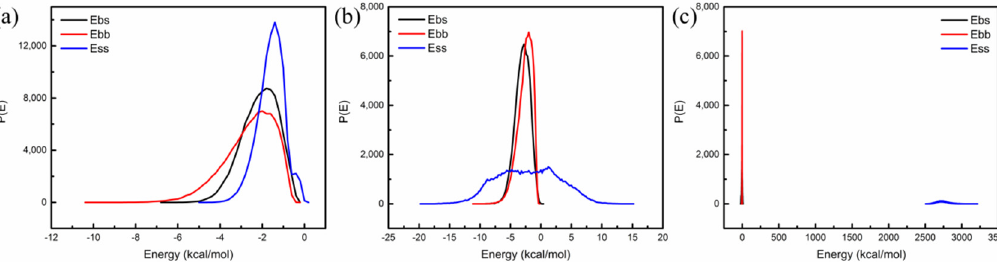
Figure 9. The probability distribution of mixing energy of traditional nanomaterials with SBS: ( a ) SiO 2 ; ( b ) ZnO; ( c ) TiO 2 .